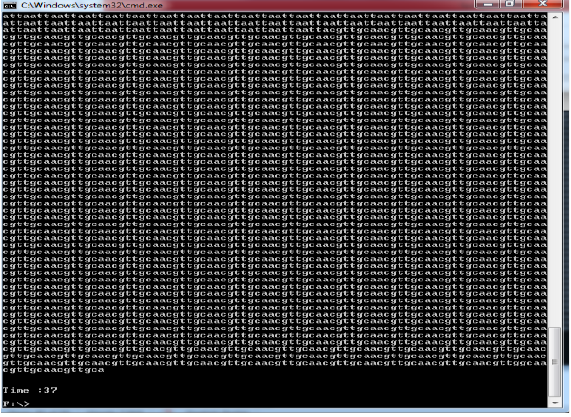
Figure 3 Decompressing DNA sequences PERFORMANCE ANALYSIS